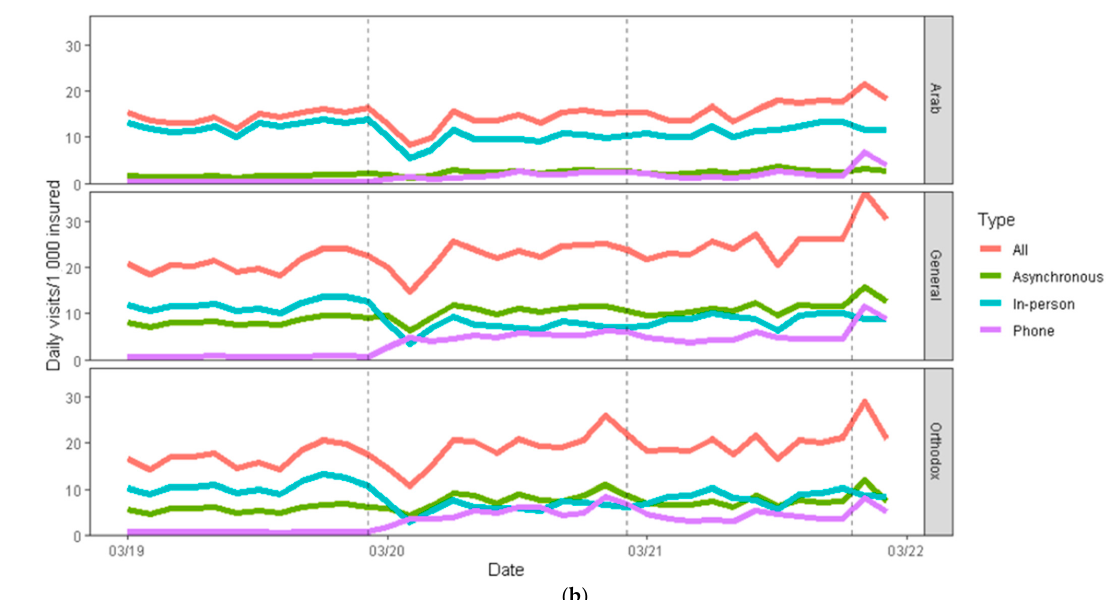
Figure 2. ( a ). Total visits by type. Y axis: primary care visits per 1000 members. X axis: the calendar month of the visit. The red line represents overall visits; the green line represents asynchronous communication; the blue line represents in-person visits; and the purple line represents phone visits. The dotted vertical lines and names indicate (from left to right) the start of the COVID-19 pandemic in Israel (March 2020), the start of the COVID-19 vaccine protective period for the majority of Israelis (March 2021), and the start of the Omicron wave (January 2022). ( b ). In-person, phone, asynchronous and total visits, by sector. Y axis: primary care visits per 1000 members in that sector. X axis: the calendar month of the visit. The red line indicates overall visits; the green line indicates asynchronous communication; the blue line indicates in-person visits; and the purple line indicates phone visits. The dotted vertical lines indicate (from left to right) the start of the COVID-19 pandemic in Israel (March 2020), the start of the COVID-19 vaccine protective period for the majority of Israelis (March 2021), and the start of the Omicron wave (January 2022).